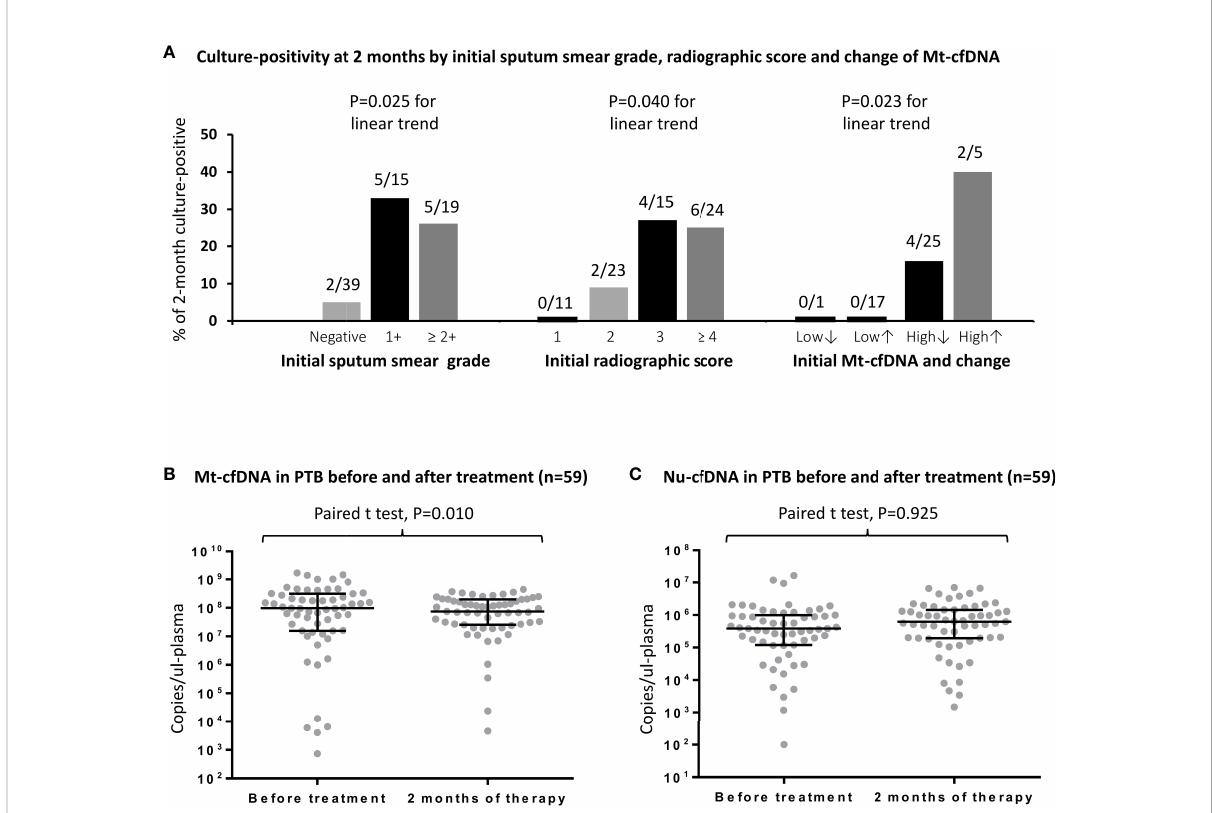
FIGURE 3 The rates and numbers (n/N) of 2-month culture-positivity in PTB patients are shown strati fi ed by initial sputum smear grade, initial radiographic score, and dynamic change of Mt-cfDNA levels (A) .The levels of human mitochondrial cell-free DNA (Mt-cfDNA) (B) and nuclear cell-free DNA (Nu-cfDNA) (C) at baseline and at 2 months of therapy in patients with pulmonary tuberculosis (PTB). Here, Mt-cfDNA levels at 2 months in the 59 patients with PTB were normally distributed and a paired t test was used. Data are presented as medians with interquartile ranges, and with each dot representing a value. Low ↓ , low Mt-cfDNA level (<62.62 x 10 6 copies/ m L-plasma) at baseline with a further decrease at 2 months; Low ↑ , low Mt-cfDNA level at baseline with a subsequent increase at 2 months; High ↓ , high Mt-cfDNA level (> 62.62 x 10 6 copies/ m L-plasma) at baseline with a subsequent decrease at 2 months; High ↑ , high Mt-cfDNA level at baseline with a further increase at 2